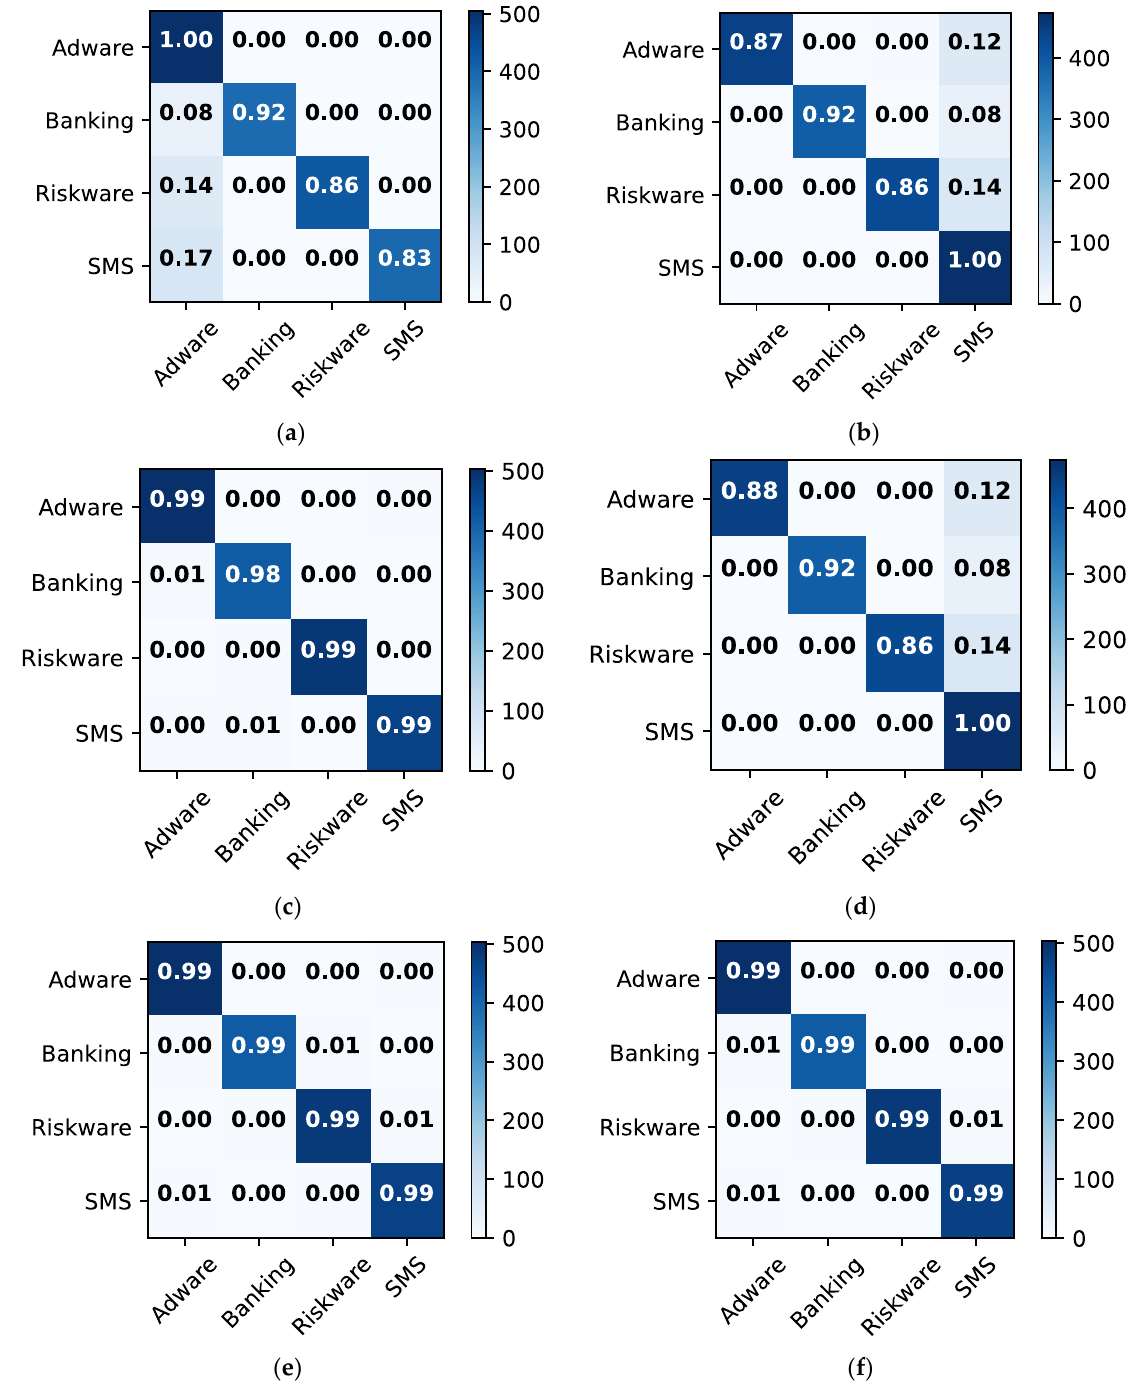
Figure 8. Confusion matrices for malware classification using dataset 2 with 256 × 256. ( a ) GNB; ( b ) SVM; ( c ) DT; ( d ) LR; ( e ) RF; ( f ) ensemble.